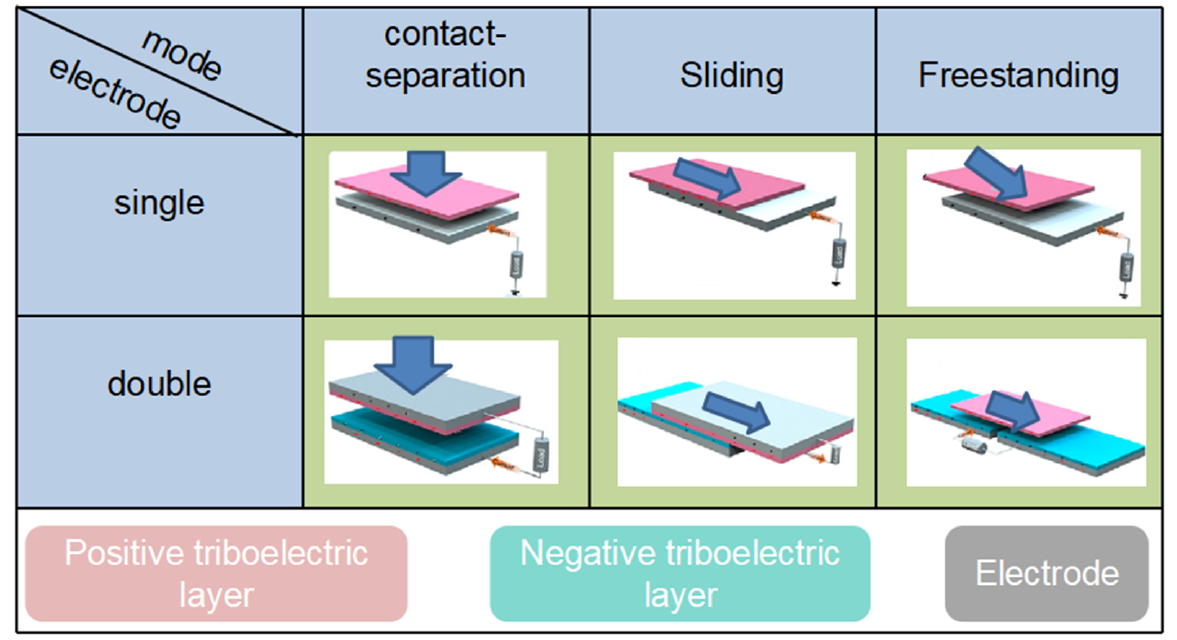
Figure 2. Working modes of TENG.